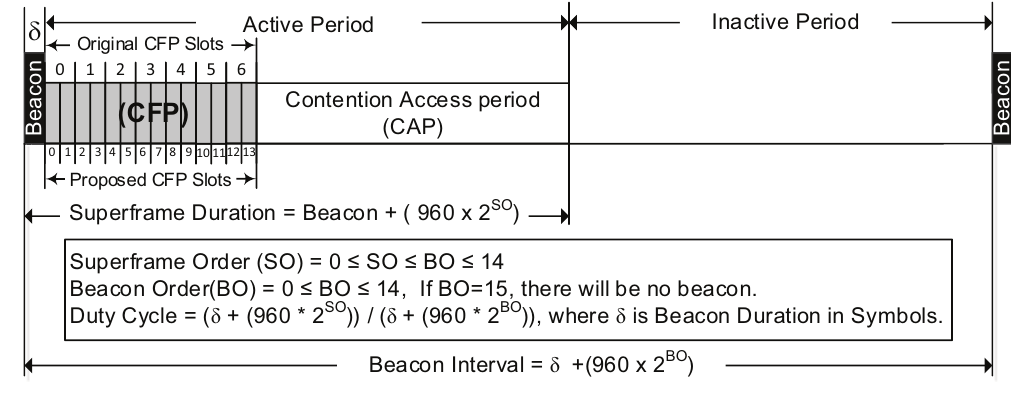
Figure 2. Efficient Superframe